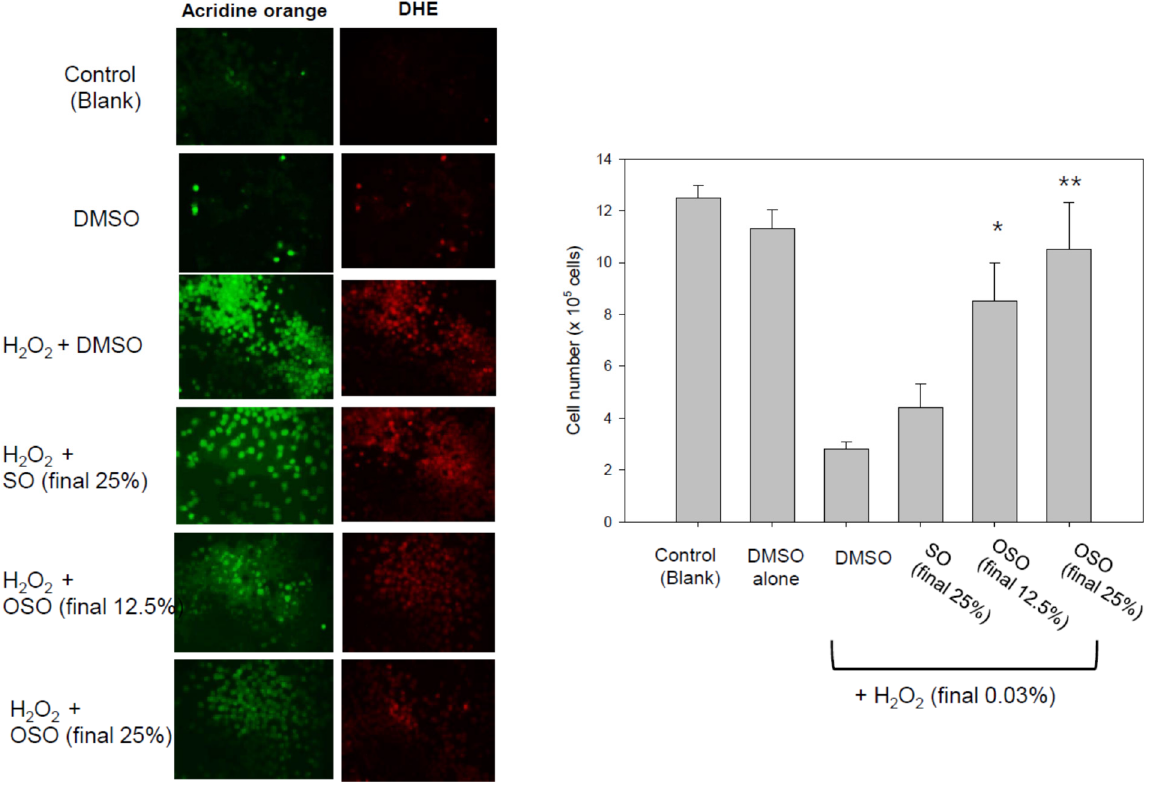
Figure 7. Cytoprotective effect of ozonated sunflower oil (OSO) in mouse brain microglial (BV-2) cells, showing the extent of apoptosis and reactive oxygen species (ROS) production in BV cells in the presence of H 2 O 2 with OSO or sunflower oil (SO). Cellular apoptosis and ROS production were determined by acridine orange (Ex = 502 nm, Em = 525 nm) staining and DHE staining (Ex = 588 nm, Em = 605 nm), respectively. The graph shows the number of BV-2 cells after treatment. * p < 0.05 compared to SO; ** p < 0.01 compared to SO.